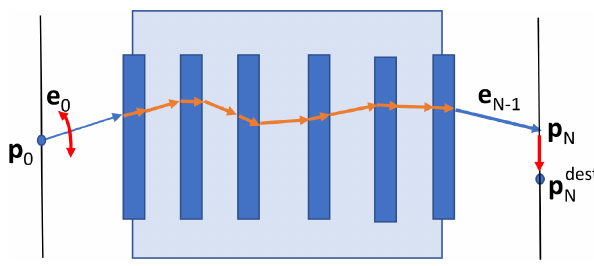
Figure 3. Ray aiming principle: the start and end points p 0 and p dest of a ray are given. The task is to find the correct start N angle e 0 such that the desired end point is hit. This is achieved by minimizing the distance between points p N and p dest reached through application of ray tracing for a chosen start direc- tion, e 0